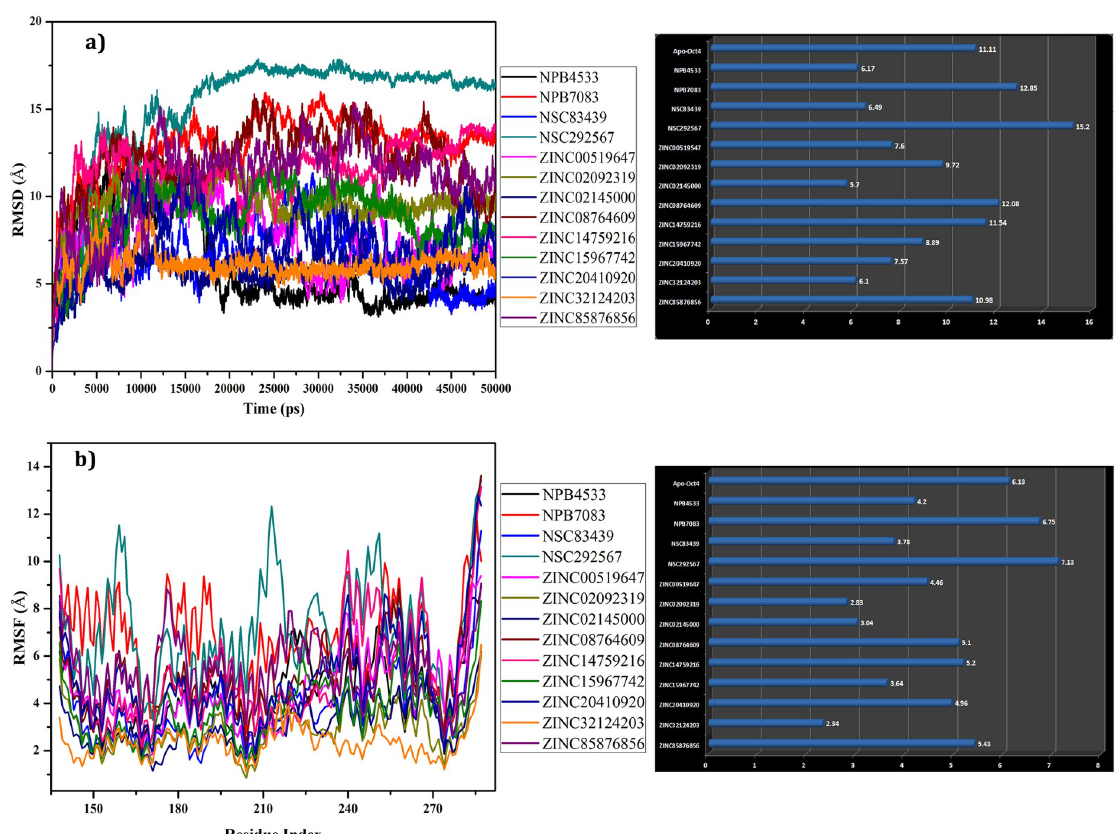
Fig 8. Molecular dynamics simulation results over 50ns. a) Time dependent RMSD ( Å ) of backbone atoms of protein displayed with average mean variation b) C-alpha RMSF of various mobile regions of the complexes with respect to the residues and mean variation plot of average RMSF